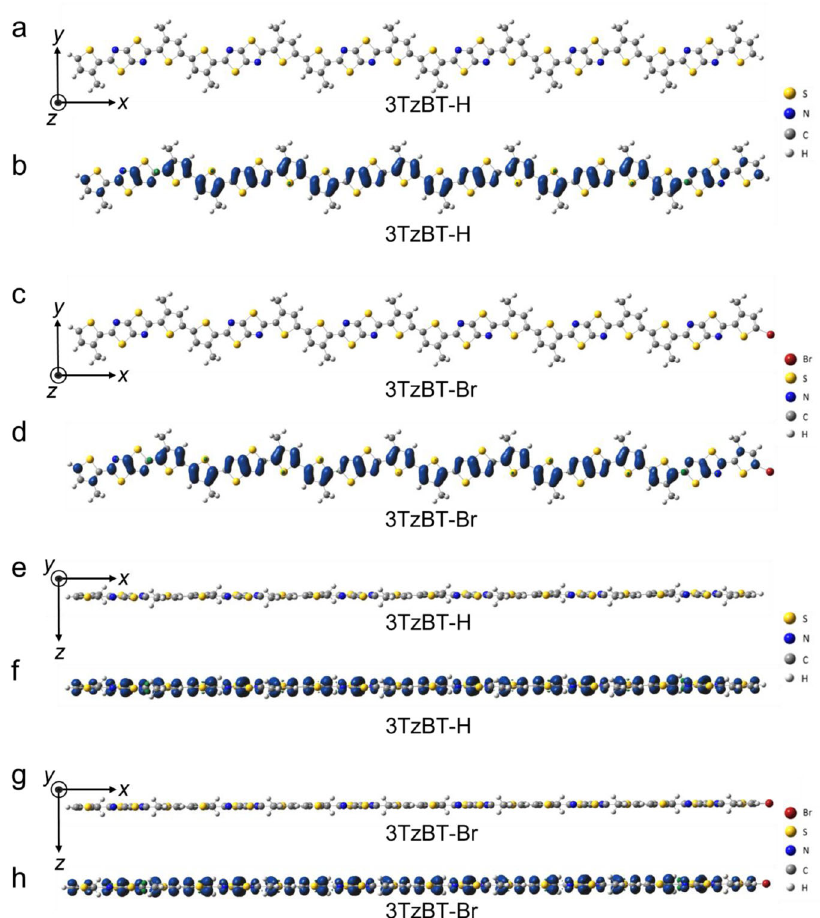
Fig. 4 Model molecules for DFT calculation and spin density distribution in cationic states. a, c Model molecules of PTzBT trimers for the DFT calculation: a 3TzBT-H, c 3TzBT-Br. b, d Spin density distribution in cationic states: b 3TzBT-H, d 3TzBT-Br. e, g Side views of model molecules of PTzBT trimers for the DFT calculation: e 3TzBT-H, g 3TzBT-Br. f, h Side views of spin density distribution in cationic states: f 3TzBT- H, h